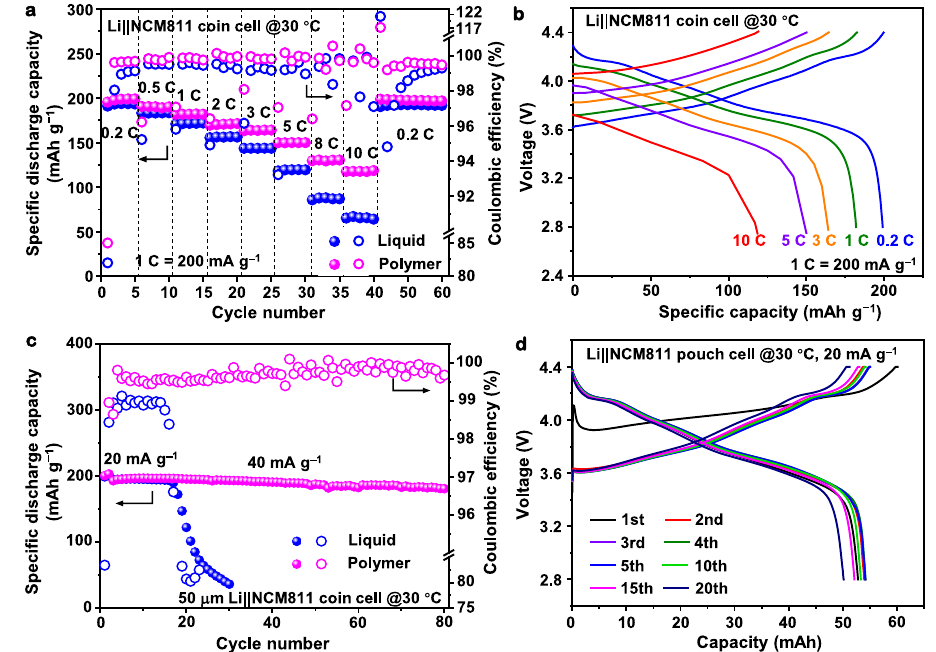
Fig. 7 | Electrochemical energy storage performances of Li||NCM811 cells with polymer or liquid electrolytes cycled at 30 °C. a Rate performances of both electrolytes, and b charge – discharge voltage pro fi les (second cycle) of the Li|| NCM811 coin cell with the designed polymer electrolyte at different applied cur- rents. In these coin cells, NCM811 cathode with a mass loading of 2.5mgcm − 2 and anodeof50 μ mLifoilwasused. c CyclingperformanceofLi||NCM811coincellswith both electrolytes under practical conditions. The fi rst two formation cycles were